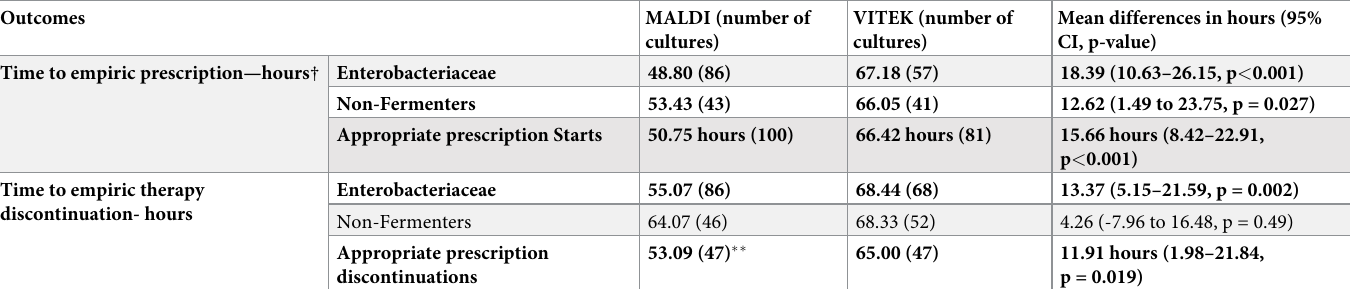
Table 4. Secondary analyses for empiric prescription and discontinuation times across MALDI vs. VITEK–enterobacteriaceae vs. Non-fermenters � ; appropriateness of therapy changes.